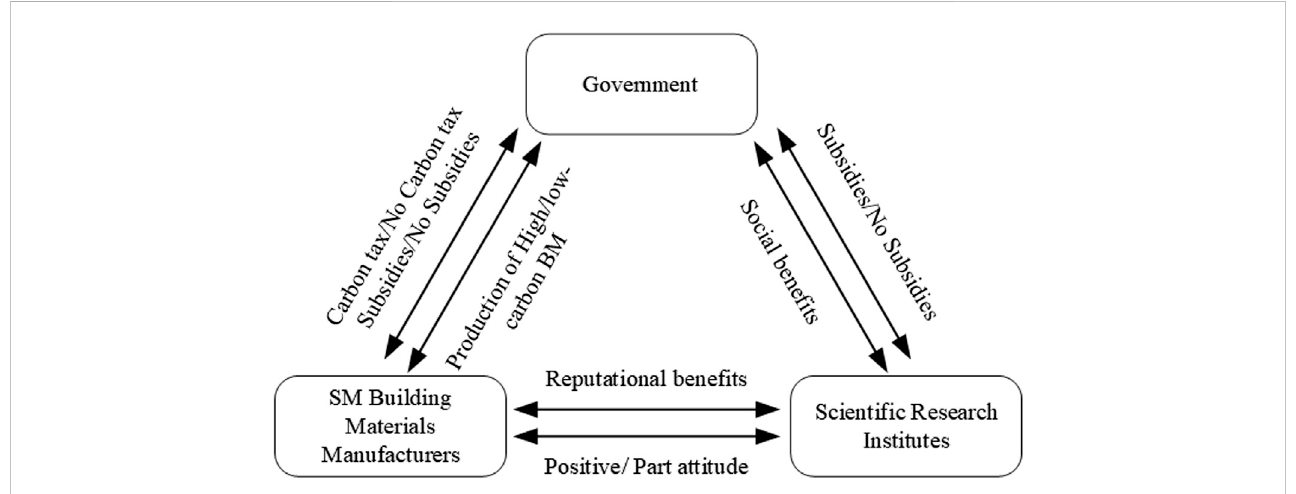
FIGURE 1 Game relationship among government, SM building material manufacturers, and scienti fi c research institutes.